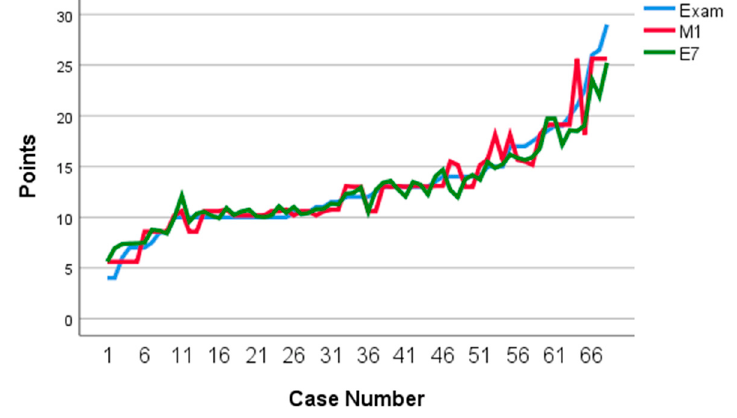
Figure 7. Line plots of the target variable Exam and its predicted values with models M 1 and E 7 .